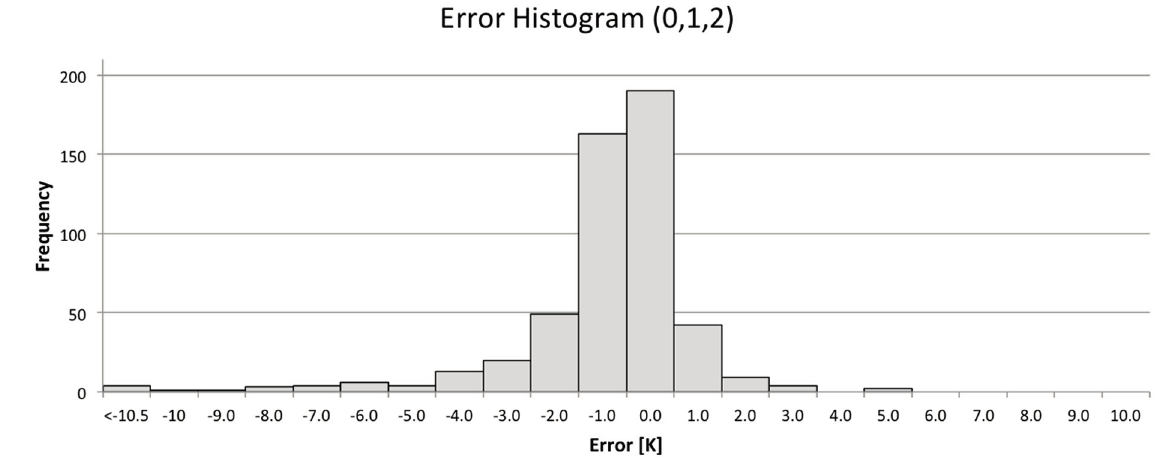
Figure 12. Histogram of errors for Landsat 5 scenes with possible clouds in the vicinity but not over the